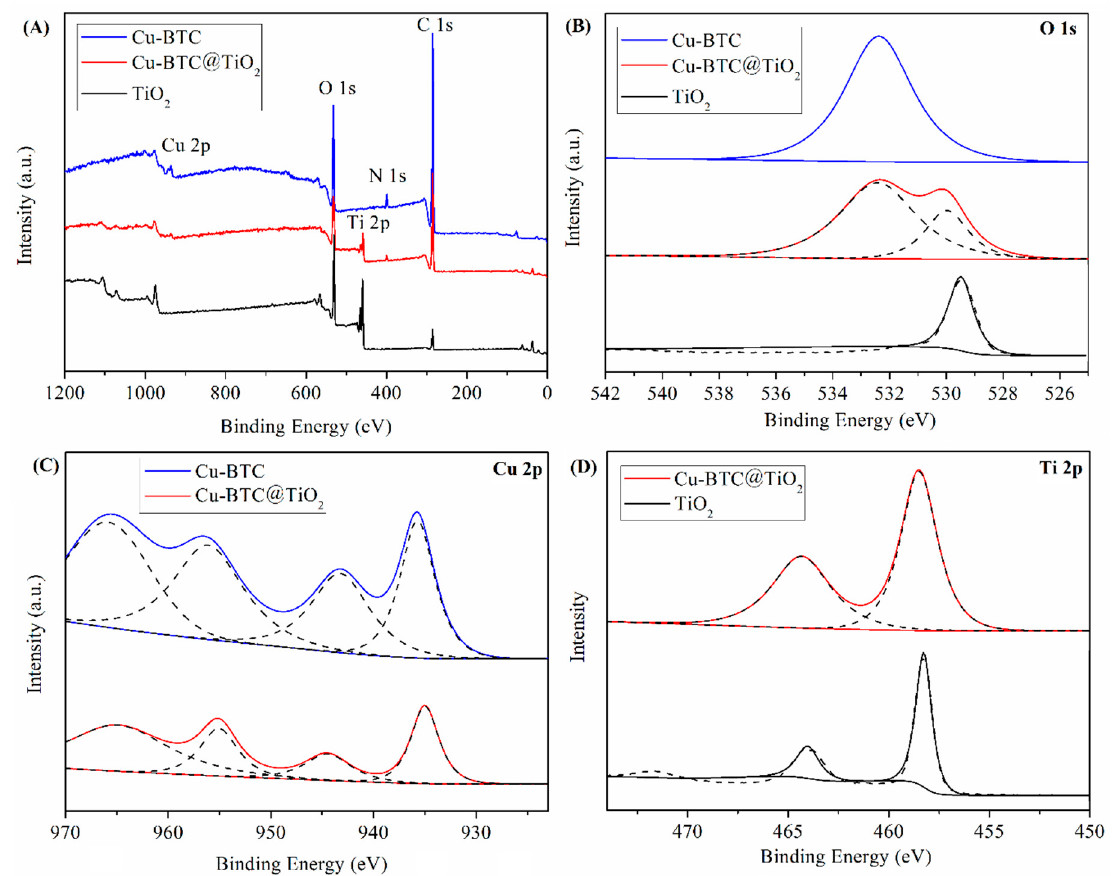
Figure 5. X-ray photoelectron spectroscopy (XPS) survey spectra ( A ) of Cu-BTC, Cu-BTC@TiO 2 and pureTiO 2 and narrow scans of the O 1s ( B ), Cu 2p ( C ), and Ti 2p ( D ) regions.